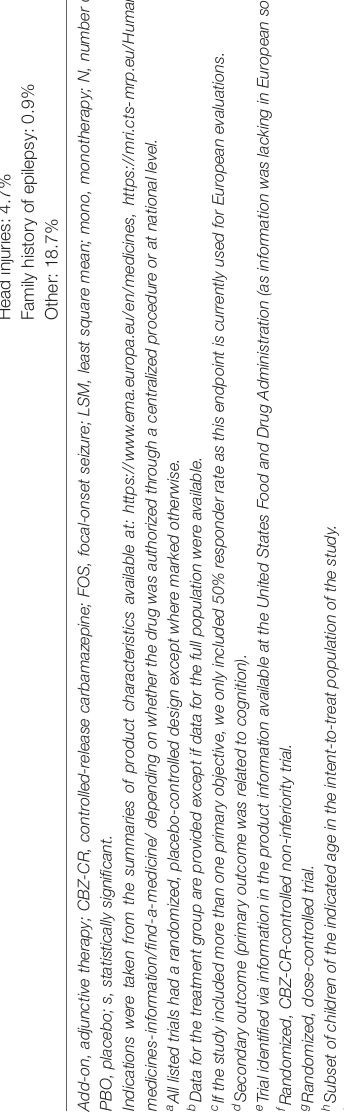
patients who did not respond to one or multiple ASMs, and efficacy estimates in these trials were often low (as expected in refractory patients; Table 1 , Supplementary Table 1 ). Moreover, only very few studies provided information on the etiology of epilepsy among enrolled patients, but none showed data segregated by etiology (and would have lacked power to conclude on such subgroup analyses). Likewise, these trials did not investigate specific childhood